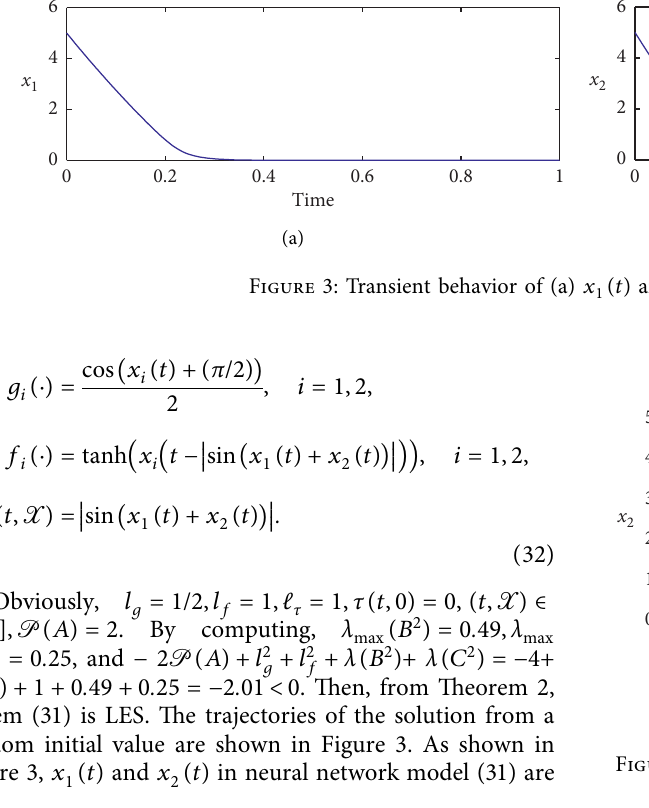
( t ) ,x ( t )) in system (28). 1 2